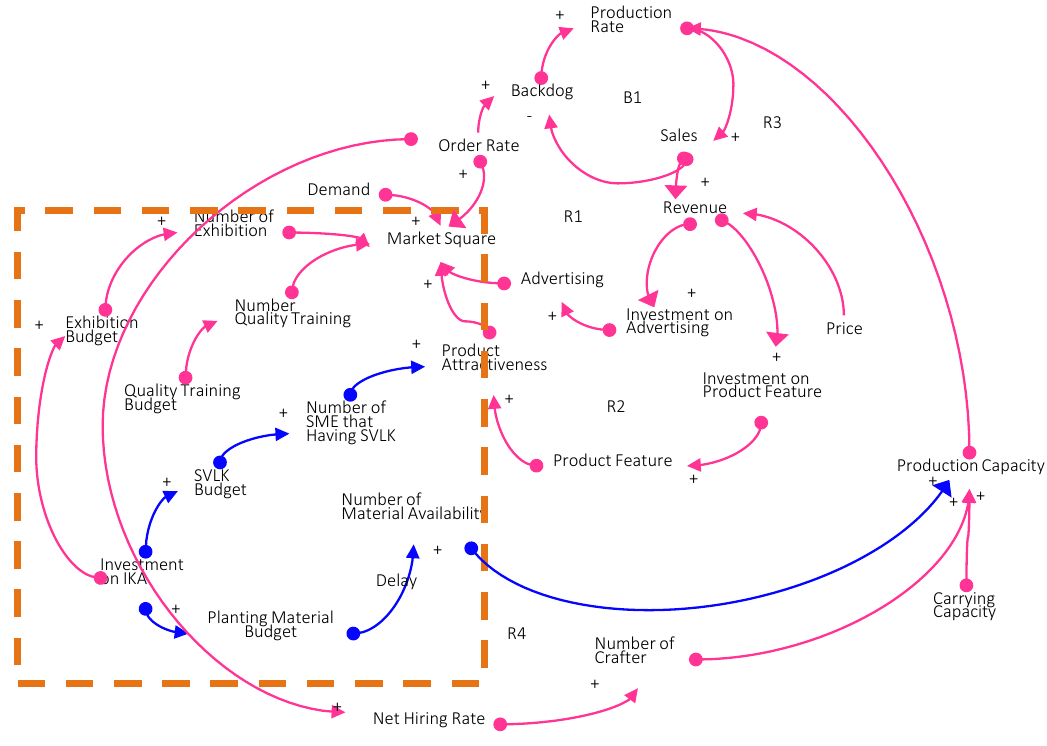
Figure 1. CLD combination of existing and improvement for